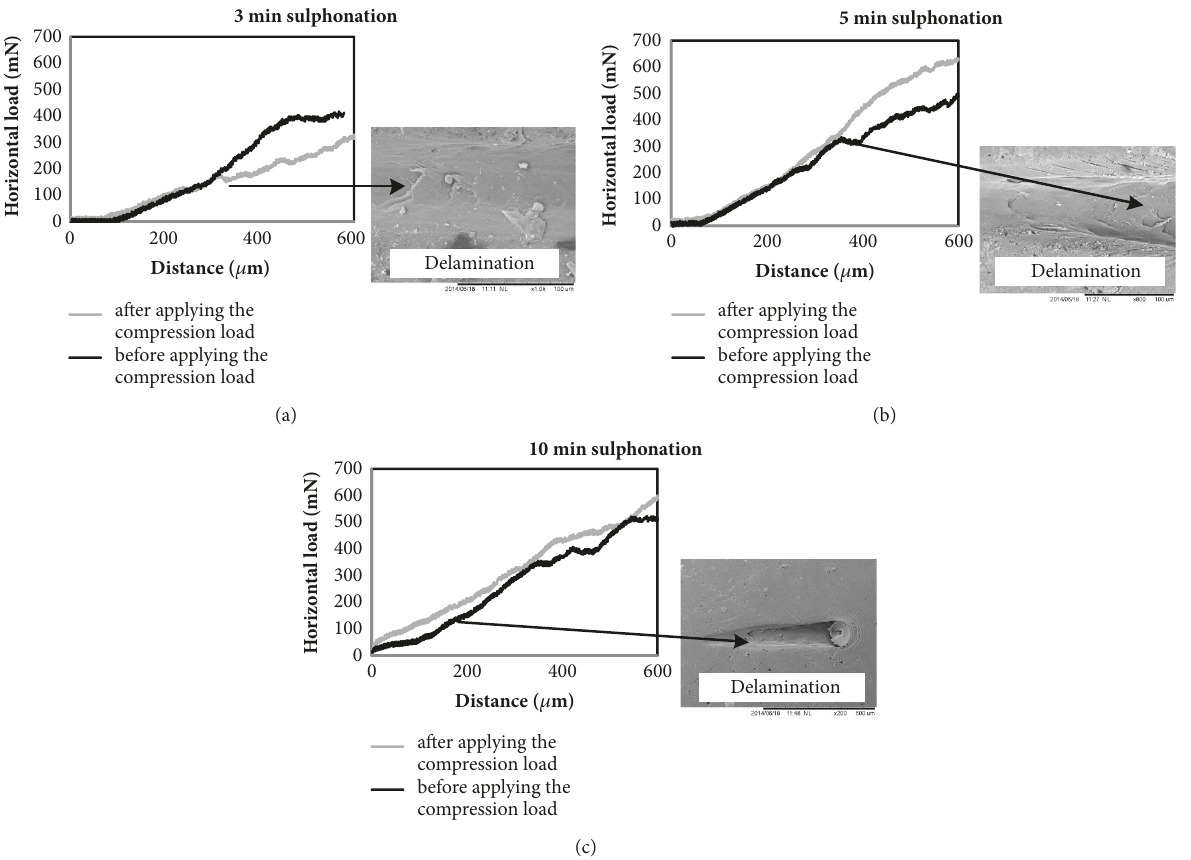
Figure 6: The effect of compression on the horizontal load/scratch distance with (a) 3-, (b) 5-, and (c) 10-minute sulphonation